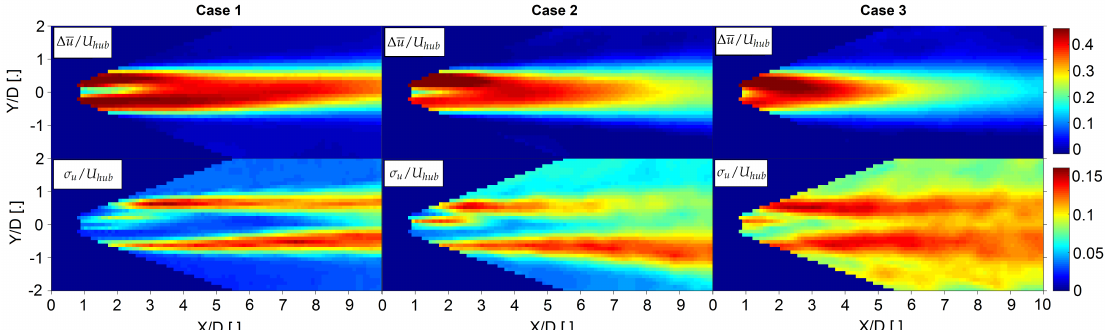
Figure 9. Example of three cases of wakes for increasing different longitudinal turbulence intensity conditions at hub height (Case 1–2.2%; Case 2–4.6%; Case 3–9.9%). The top quadrants present the adimensional velocity deficit while the bottom quadrants present the longitudinal turbulence intensity in the horizontal plane at hub height. These three example cases are further referenced in Figures